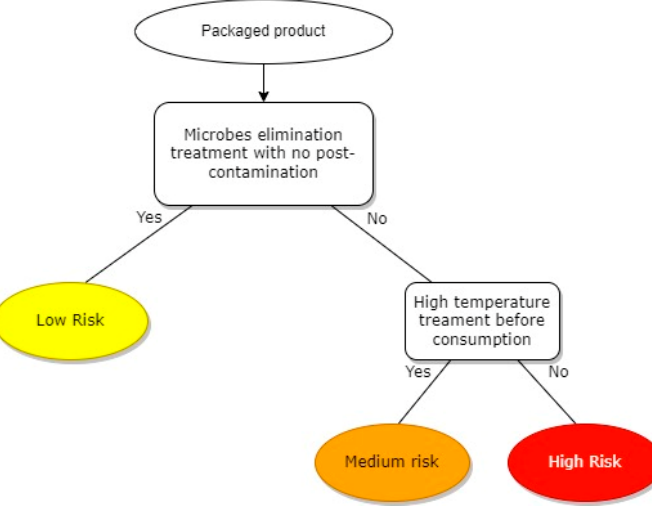
Figure 3. Example of a decision tree.